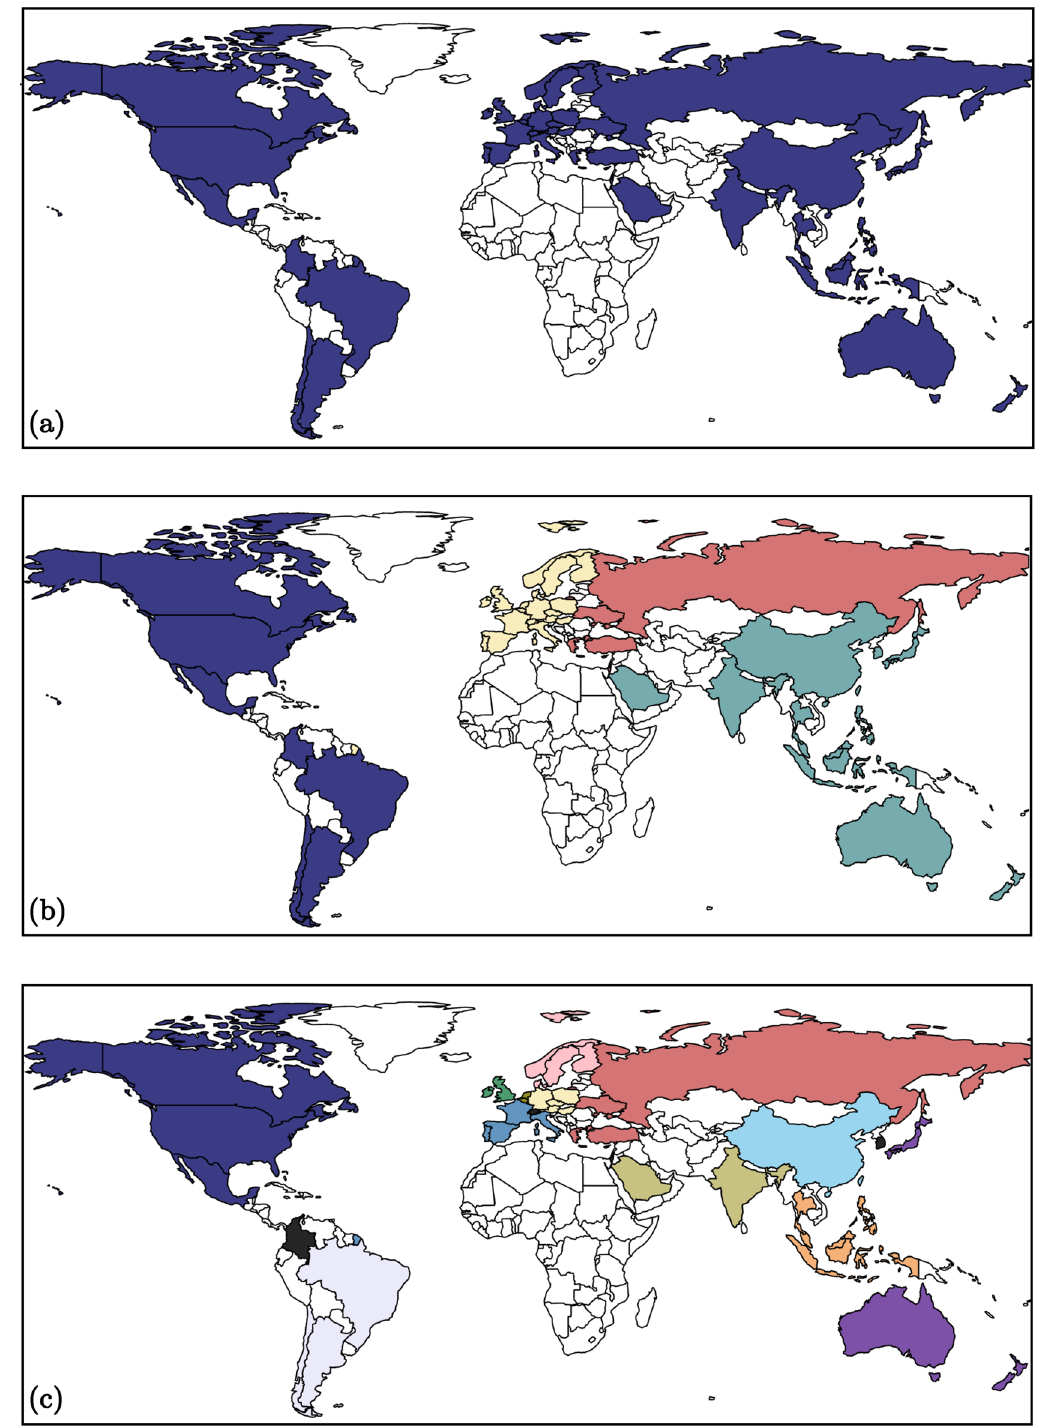
Figure 4. The configurations of countries at the selected cooccurrence thresholds illustrated by the world map. ( a ) The configuration at (cid:31) ∗ = 0 . ( b ) The configuration at (cid:31) ∗ = 0.41 . ( c ) The configuration at (cid:31) ∗ = 0.96 . Different colors represent different components except the following cases; the countries that do not belong to a component with any other countries are colored in black, and the unselected countries are colored in